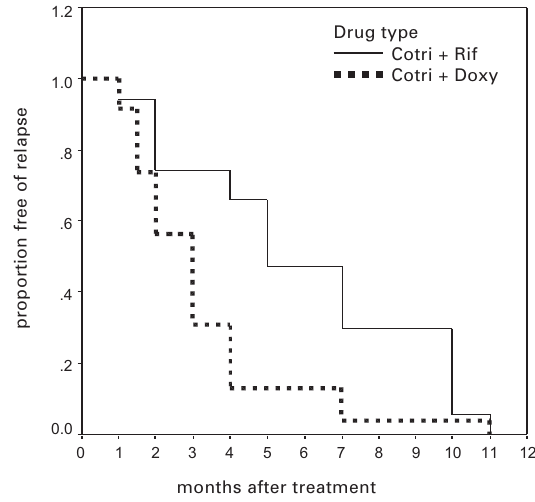
Cumulative propor- tion of patients with no relapse in each study group. After adjustment for base- line characteristics in Cox model, the risk of relapse was 1.16 times higher in the co-trimoxazole plus rifampin group than in the co-trimoxazole plus doxycycline group (p =